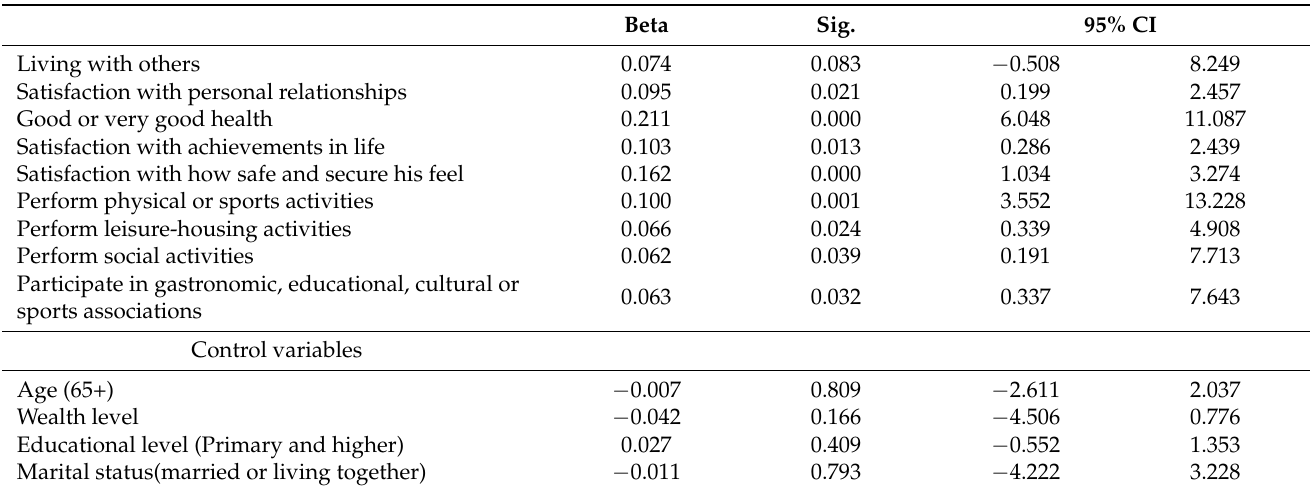
Table 5. Model weights of each predictor and their significance on the dependent variable for men. Beta